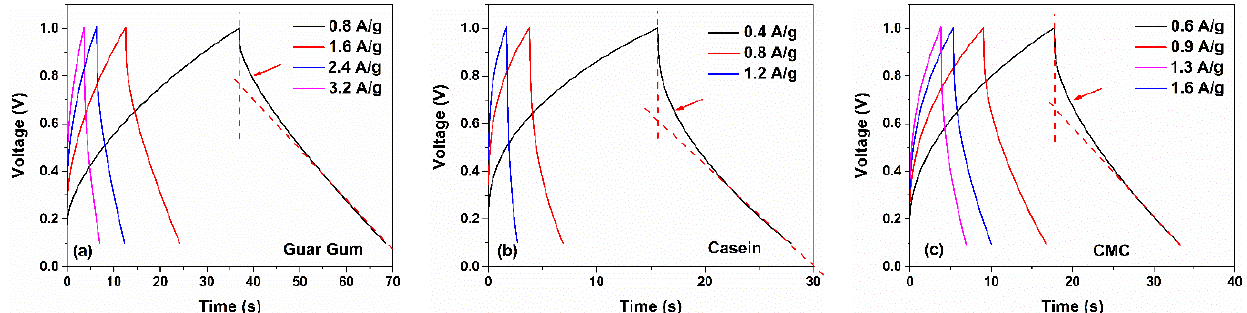
Figure 6. Galvanostatic charge and discharge curves at various current densities for the ( a ) guar gum, ( b ) casein and ( c ) CMC-based supercapacitors in 1 M NaCl electrolytes, respectively.